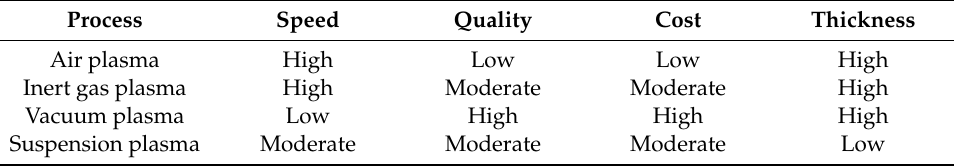
Table 2. Comparison between characteristics of di ff erent modes of plasma spray